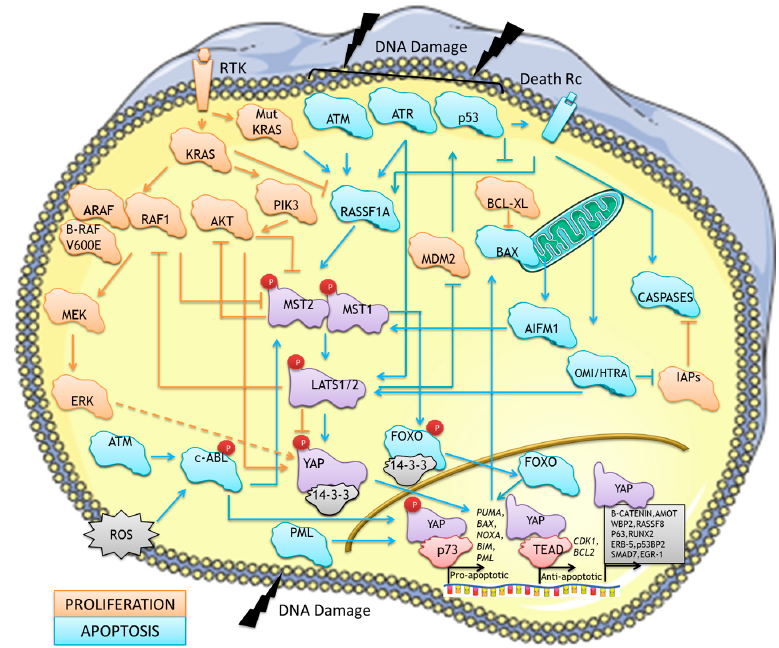
Figure 2. The cross-talk of mammalian Hippo signalling with the MAPK, PI3K and intrinsic and extrinsic apoptotic pathways. The scheme represents the MST/Hippo signalling network that regulates the pro-apoptotic signals mediated by the core proteins of the pathway. The proliferative signals are represented in orange, meanwhile the pro-apoptotic signals are represented in blue. The black box illustrates the described interactors binding to